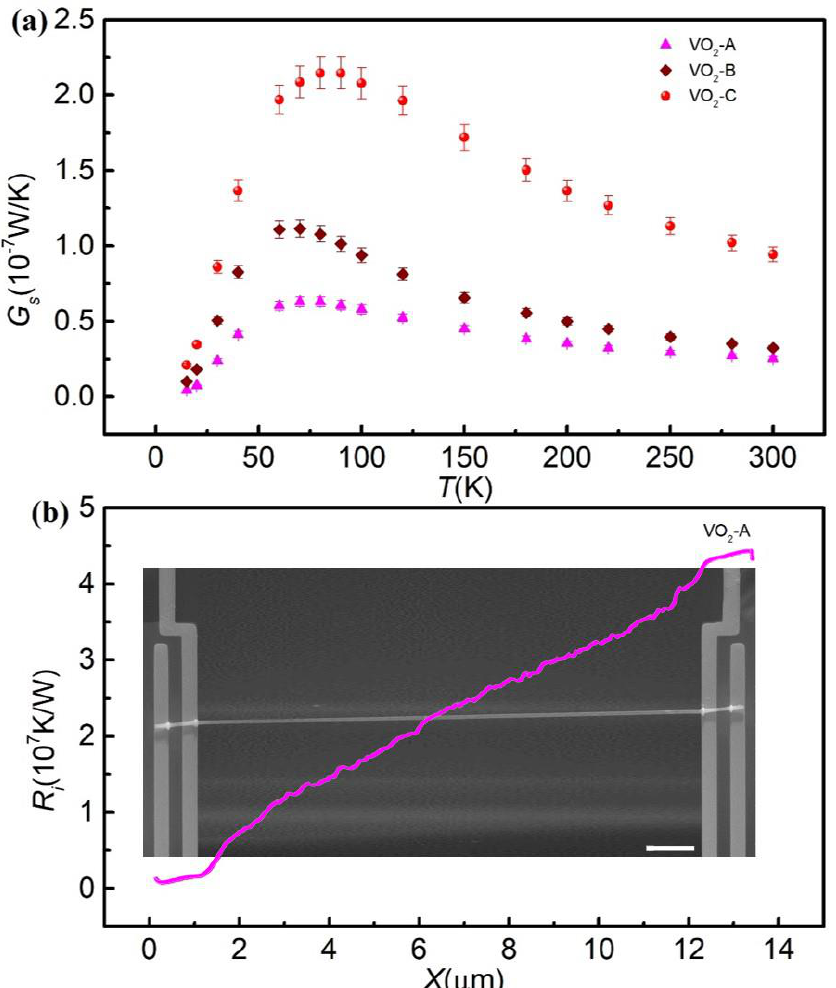
Figure 1. ( a ) Thermal conductance of the measured three VO 2 nanowires as a function of temperature. ( b ) The intrinsic thermal resistance measured by the electron beam self-heating method varies with the scanning position of the electron beam for VO 2 -A. Inset: scanning electron microscopy images of the VO 2 nanowires. The scale bar is 2 μ m. Table 1. Parameters of the VO 2 nanowires used for the thermal conductance. The lengths and diam- eters of the VO 2 nanowires were measured by SEM.